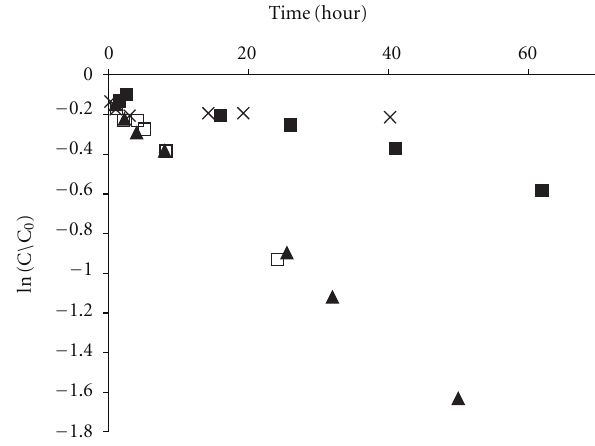
Figure 4: Changes in the concentration of R6G during pho- todegradation under the following conditions: open circuit (filled squares), short circuit (crosses),and a positive bias of 200mV (filled triangles), a positive bias of 400mV (empty squares). The data is based on absorbance measurements at